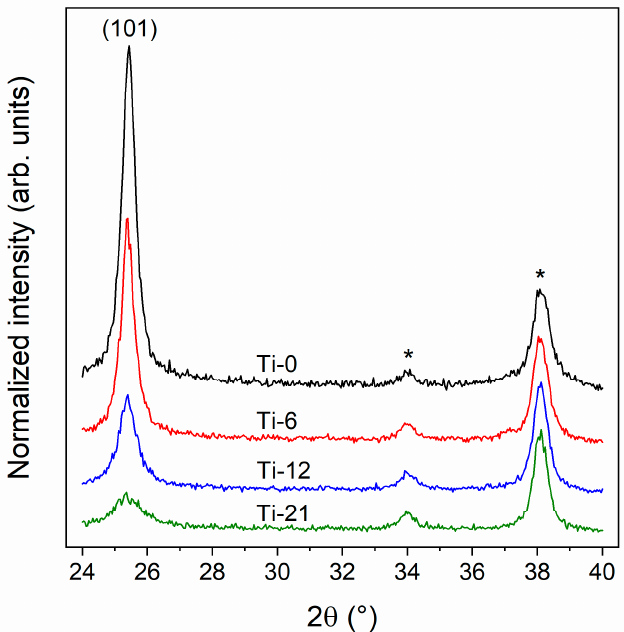
Figure 1. XRD diffractograms of TiO 2 films with different block co-polymer content deposited on FTO substrates. The (101) reflection of the anatase phase is indicated in the figure. The asterisks (*) indicate reflections from the underlying FTO substrate. The diffractograms have been normalized to the intensity of the FTO reflection at 38.1° 2 θ as well as offset for clarity.